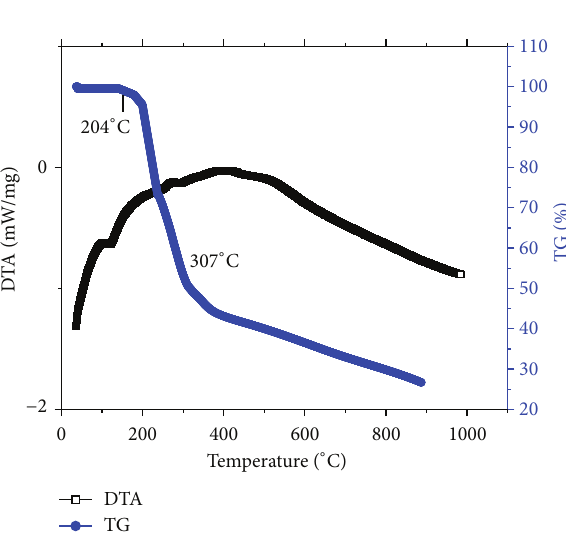
Figure 6: TGA and DTA traces of LSP